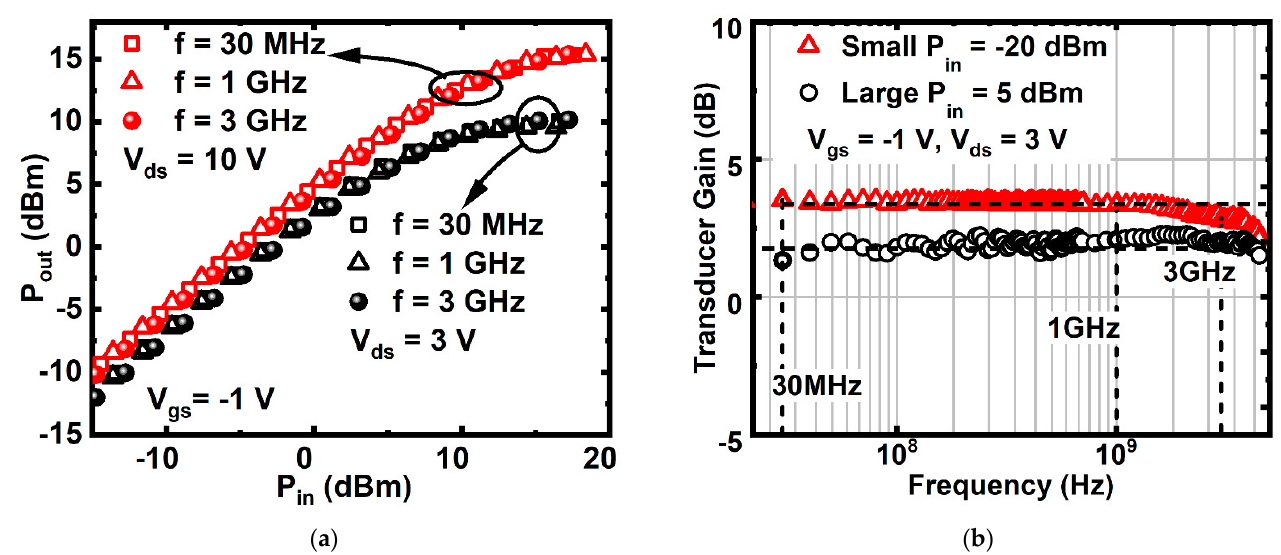
Figure 5. ( a ) P out versus P in with 30–3000 MHz; ( b ) transducer gain versus frequency at V gs /V ds = − 1/3 V.